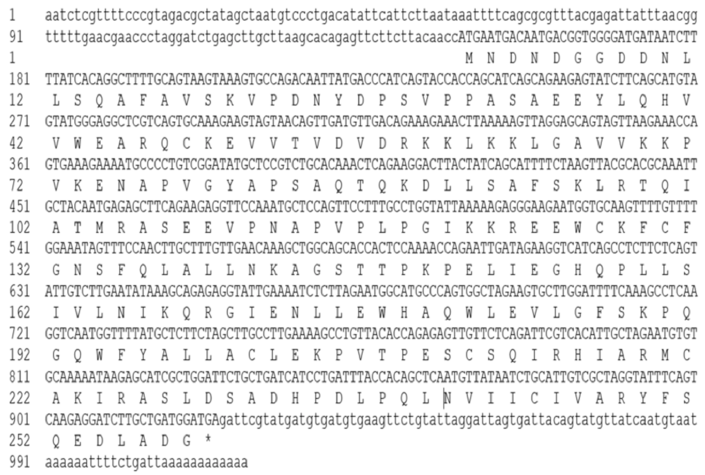
Figure 1. Nucleotide and deduced amino acid sequence of Mn-GEM . The nucleotide sequence is displayed in the 5 ′ –3 ′ directions and numbered at the left. The deduced amino acid sequence is shown in a single capital letter amino acid code. 3 ′ UTR (untranslated region) and 5 ′ UTR are shown with lowercase letters. Codons are numbered at the left with the methionine (ATG) initiation codon, an asterisk (*) denotes the termination codon